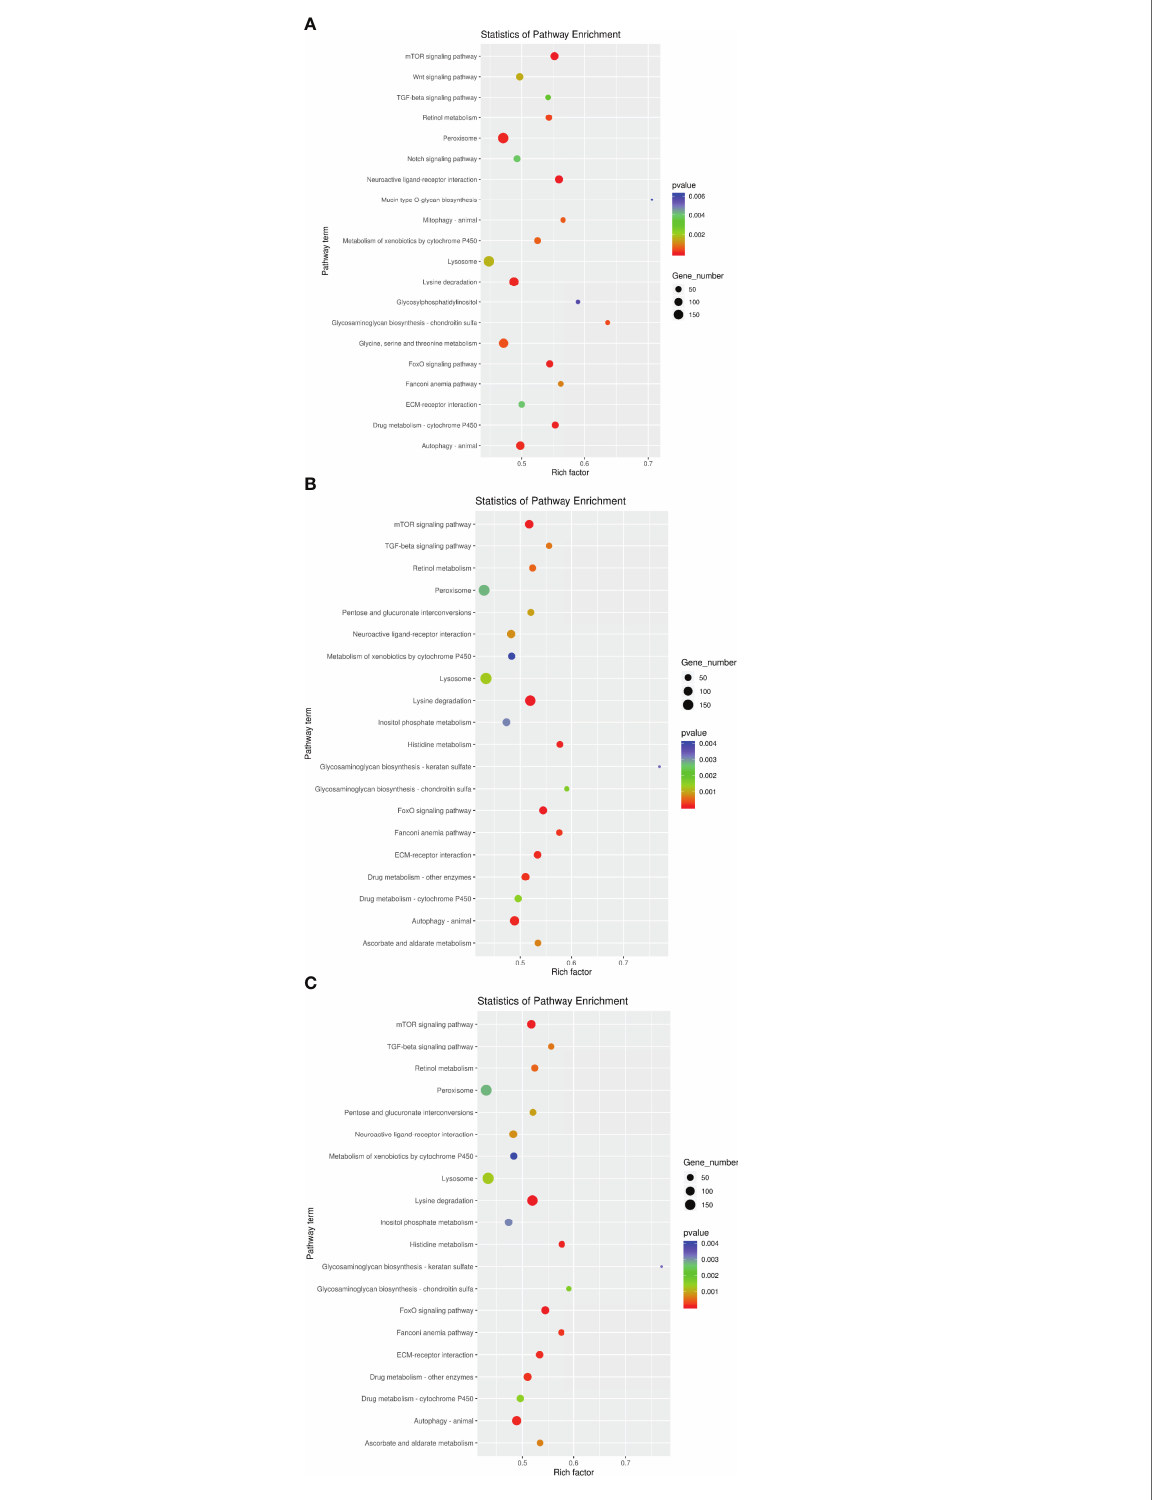
FIGURE 5 | KEGG enrichment of target genes of DEMs. The x-axis is the rich factor, which means that the proportion of target genes in total genes in a KEGG term. The y-axis is the gene functional classi fi cation of KEGG. Various colors of plots indicate different values of − log 10 ( P -value). Plot diameter represents target gene numbers in a KEGG term. (For interpretation of the references to color in this fi gure legend, the reader is referred to the Web version of this article). (A) HT VS NT, (B) LO vs NT, (C) HL vs